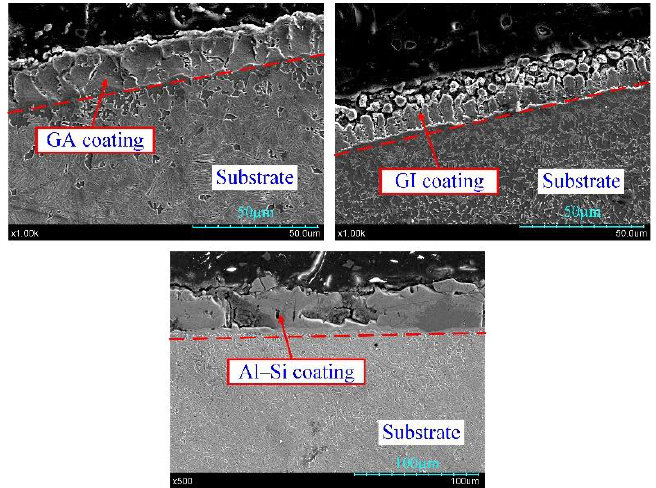
Figure 9. The microstructure of coatings at T 14 in region E.